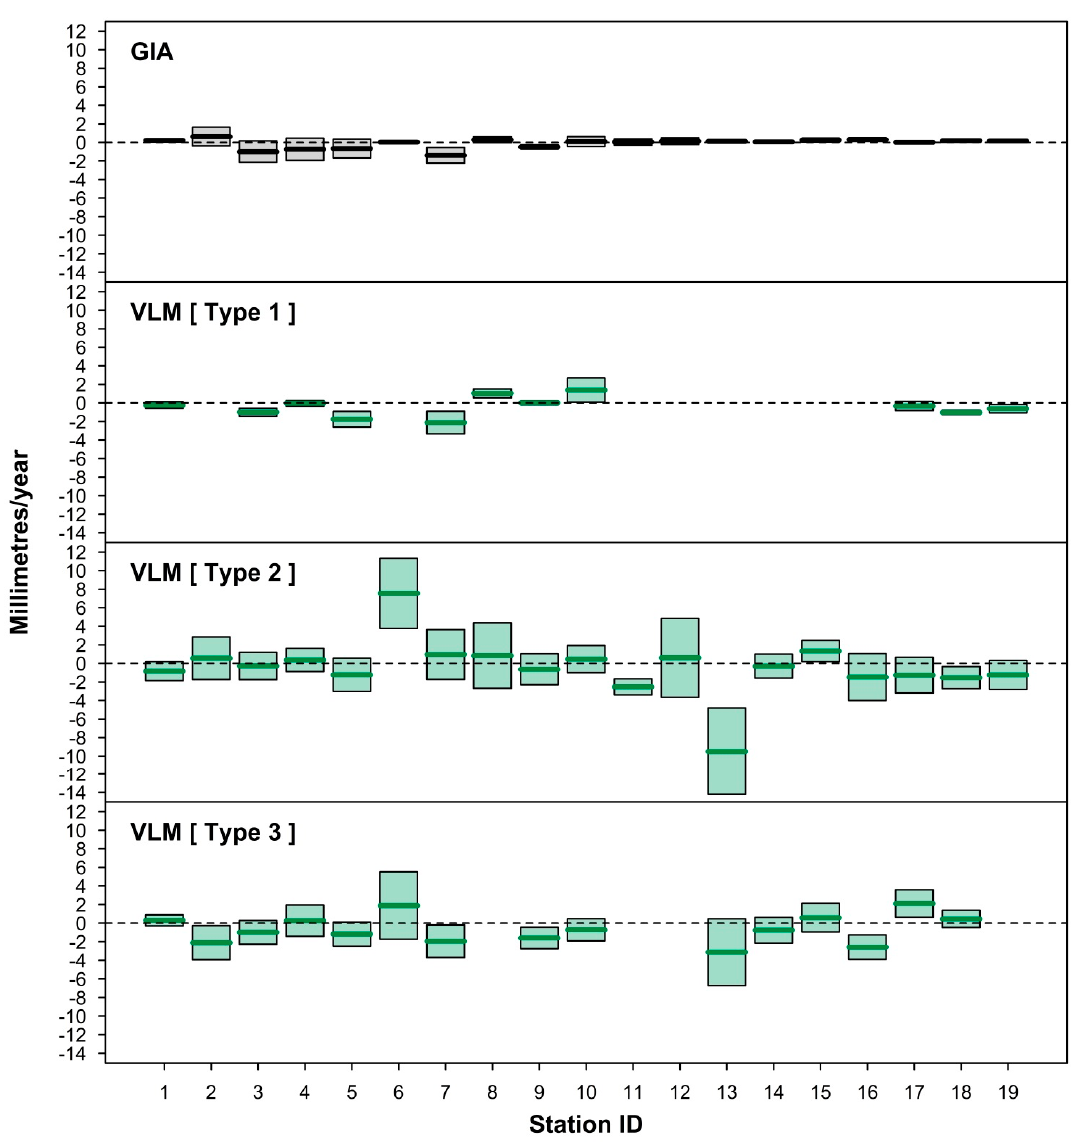
Figure 7. Comparison of VLM and GIA rates for each station record. GIA estimates are those used in AR5 [5] based on an average of Peltier [33] and Lambeck [34] provided by ICDC [6]. “Type 1” VLM are based on ULR6 GPS solutions [30] provided by SONEL [29]. “Type 2” VLM are based on the difference between the annual time series from satellite altimetry [14] and the tide gauge using the procedure advised in Ostanciaux et al. (2012) [31]. “Type 3” VLM are based on the procedure advised in Pfeffer and Allemand (2016) [32]. Error margins depicted in each panel are 95% CL. Refer to Figure 1 and Table 1 for station ID details.